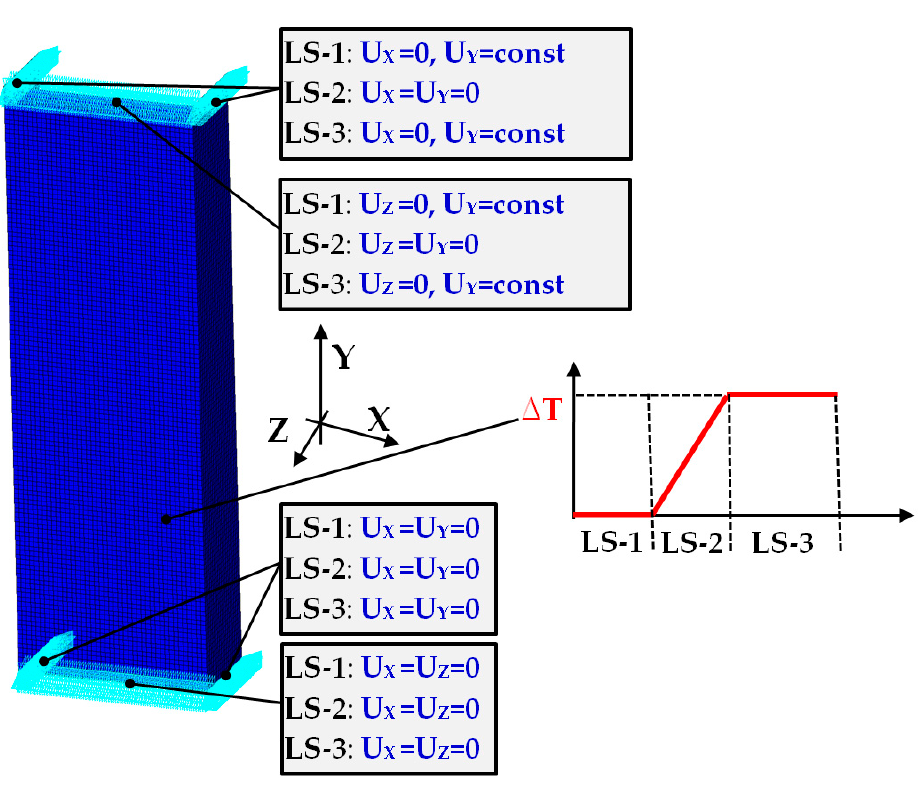
Figure 9. Boundary conditions of FEM_SHELL_2.